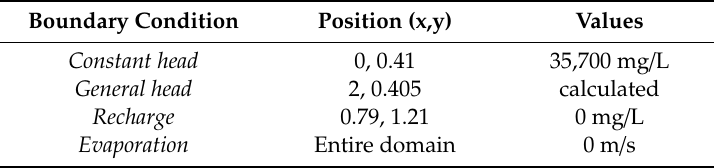
Table 2. Boundary condition and concentration values.